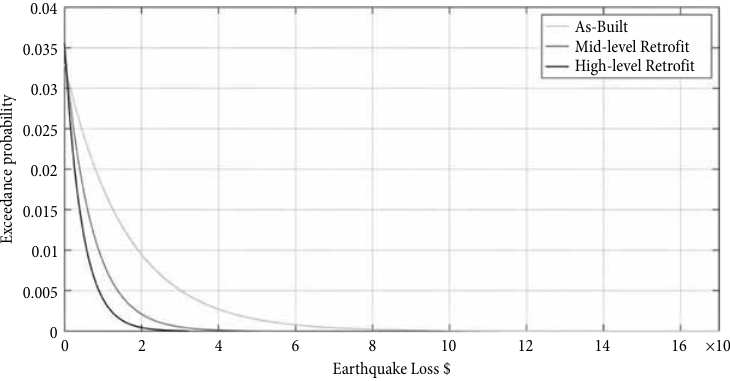
Fig. 2. EP curves for different retrofit levels